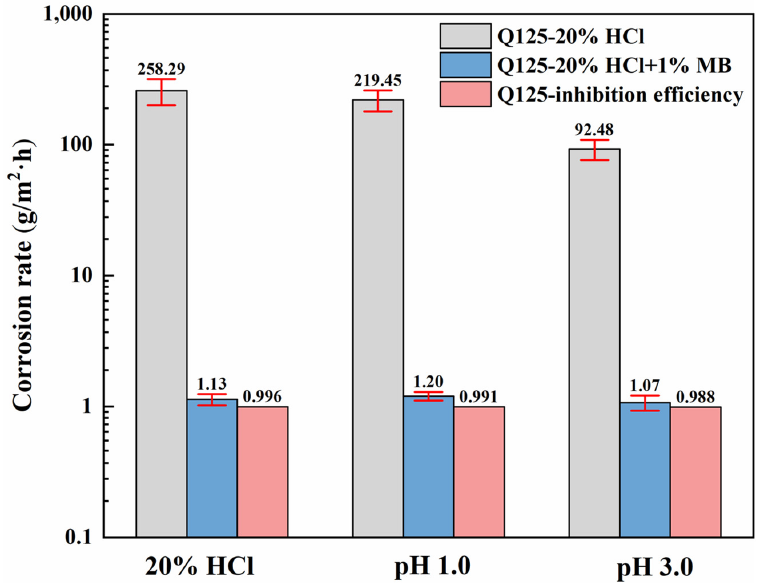
Figure 2. Uniform corrosion rate of casing steel immersed in fresh and residual acid solutions with or without Mb inhibitor for 4 h at 90 °C.